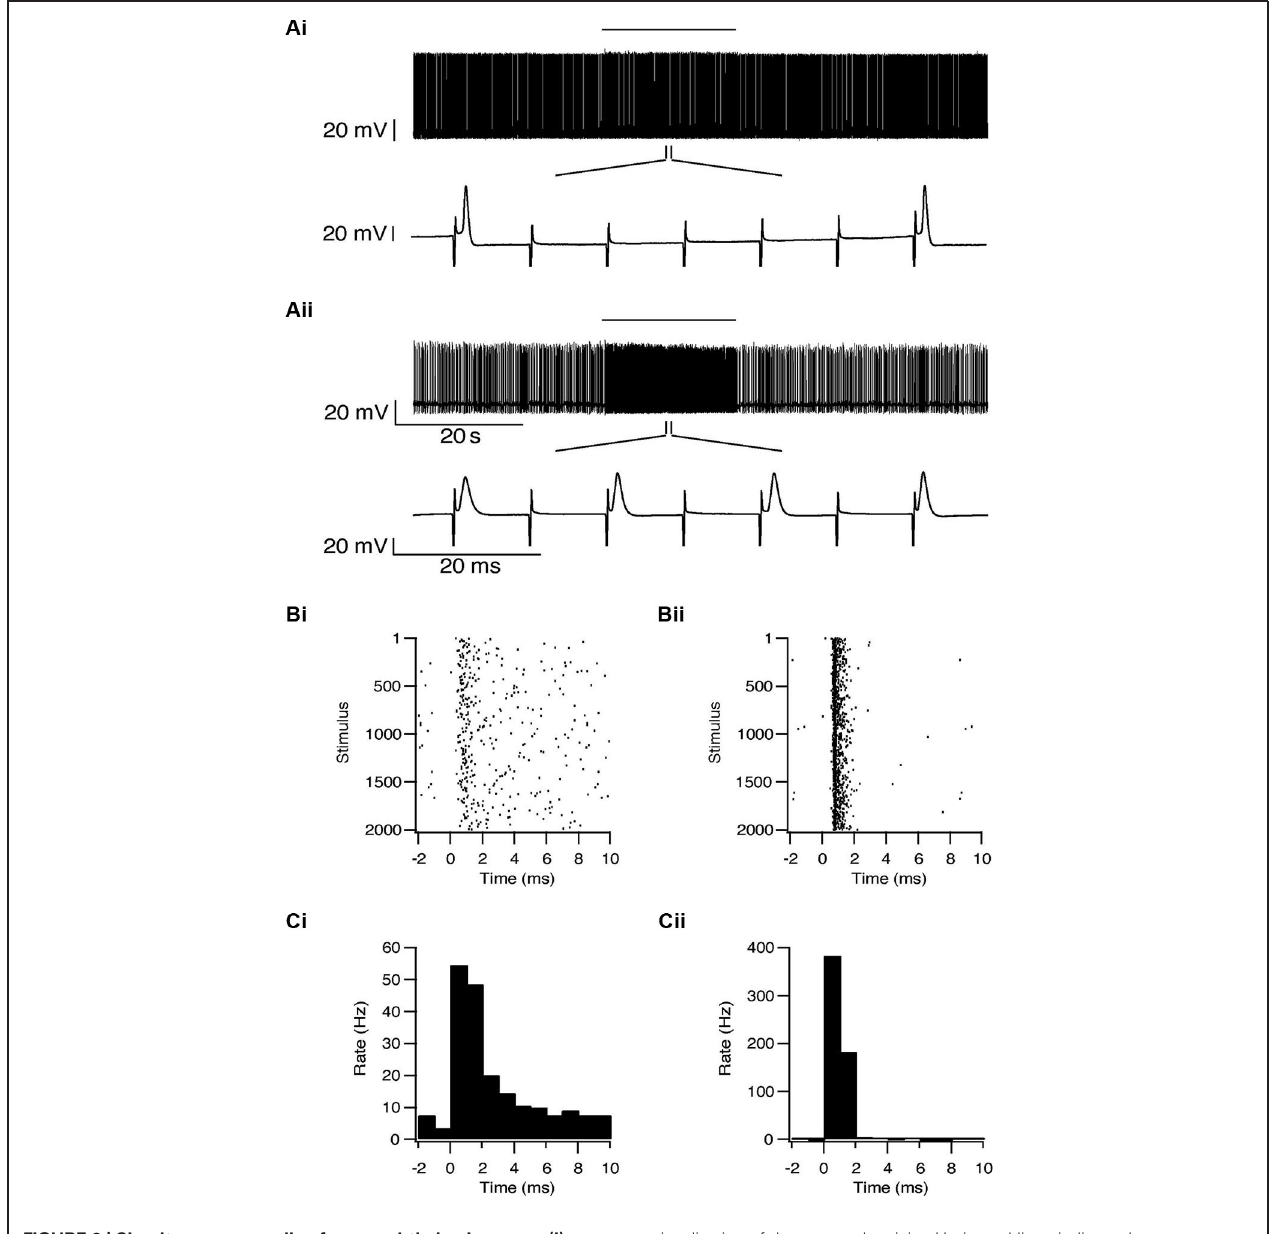
visualization of the neuronal activity. Horizontal lines indicate the stimulation period. (B) Raster plots of responses to each pulse constructed from all repetitions ( n = 2000). (C) Peristimulus time histogram